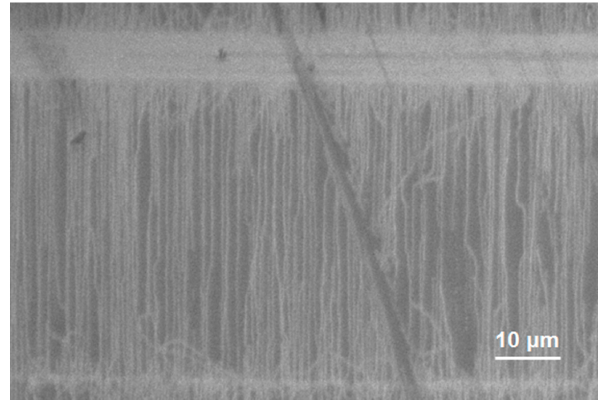
Figure 3. Field emission scanning electron microscopy image of horizontally aligned carbon nanotubes on quartz substrate.